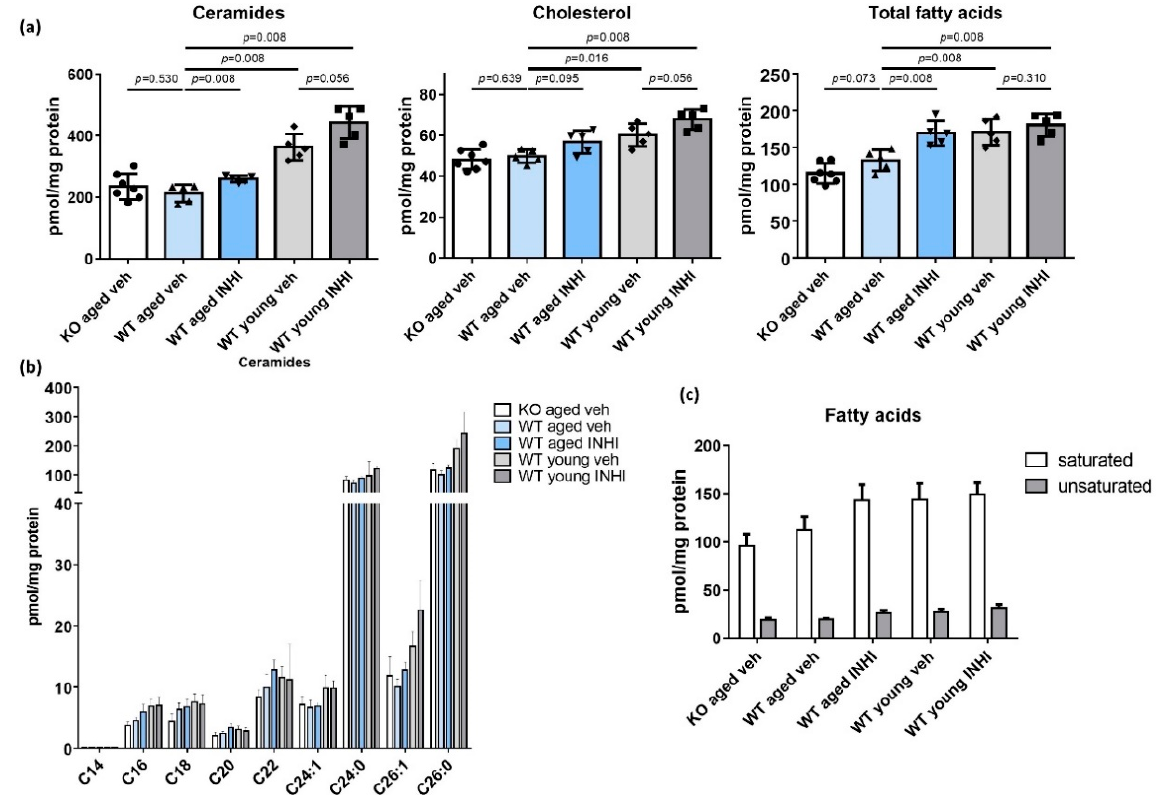
Figure 6. Lipid analysis of HSD11B1 knock-out (KO) and wild type (WT) mice. ( a ) The levels of three major types of SC lipids (ceramide, cholesterol, and free fatty acids (free FAs)) were significantly lower in aged WT mice than in young WT mice after treatment with the vehicle ( p < 0.05 in each case). Topical INHI treatment led to a recovery of the levels of all three lipid types in both the aged and young WT mice. The levels of ceramide and total FAs increased significantly in the aged mice after INHI treatment (each p = 0.008), whereas the cholesterol level did not ( p = 0.095). The extent of these increases was smaller among young mice. There was no difference between the levels of all three lipid types in the aged HSD11B1 KO mice and aged WT mice. ( b ) The ceramide levels were evenly reduced in the aged WT and aged HSD11B1 KO mice regardless of the number of carbons in the fatty acyl chains. ( c ) In the aged mice, free FA levels were also low regardless of the presence of saturation. The data are presented as the means ± SD. INHI, 11 β -HSD1 inhibitor; veh, vehicle.